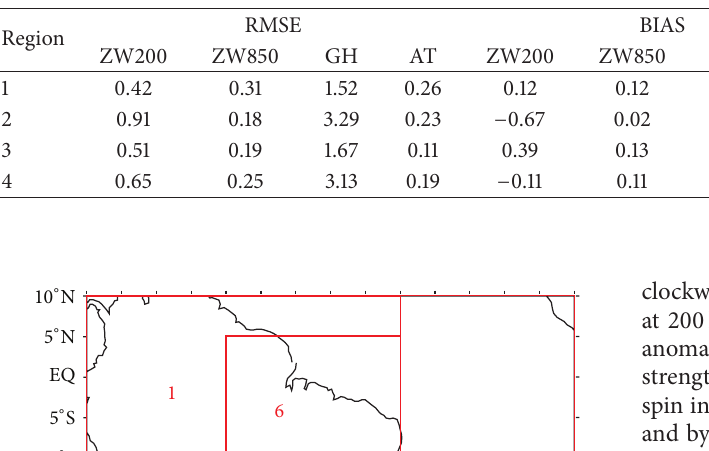
Table 2: Area averaged root mean square error (RMSE) and bias and spatial correlation coefficient (CC) for the zonal wind (ms − 1 ) at 200 hPa (ZW200) and 850 hPa (ZW850), geopotential height (m) at 500 hPa (GH), and air temperature (K) at 925 hPa (AT) anomalies for HCSA strong cases over the first four regions of Figure 5.